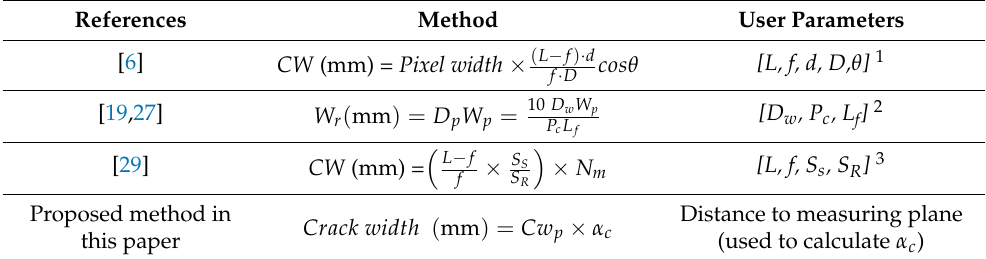
Table 2. Comparison of image-based crack width measurement